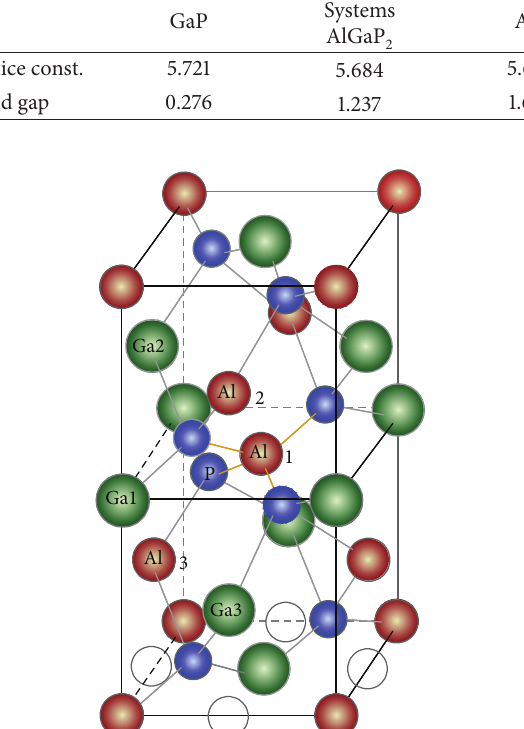
Figure 1: Crystal structure of chalcopyrite AlGaP 2 . Open-circles represent interstitial sites in a layer. The numbers of 1, 2, or 3 denote the substitutional sites by Mn